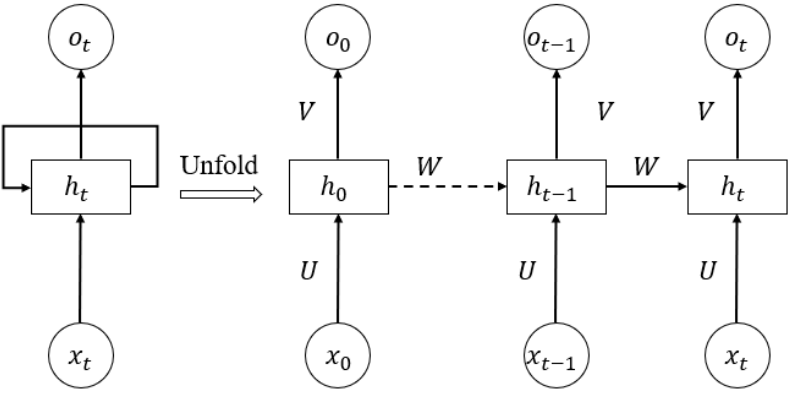
Figure 1. The structure of a neuron of a recurrent neural network.